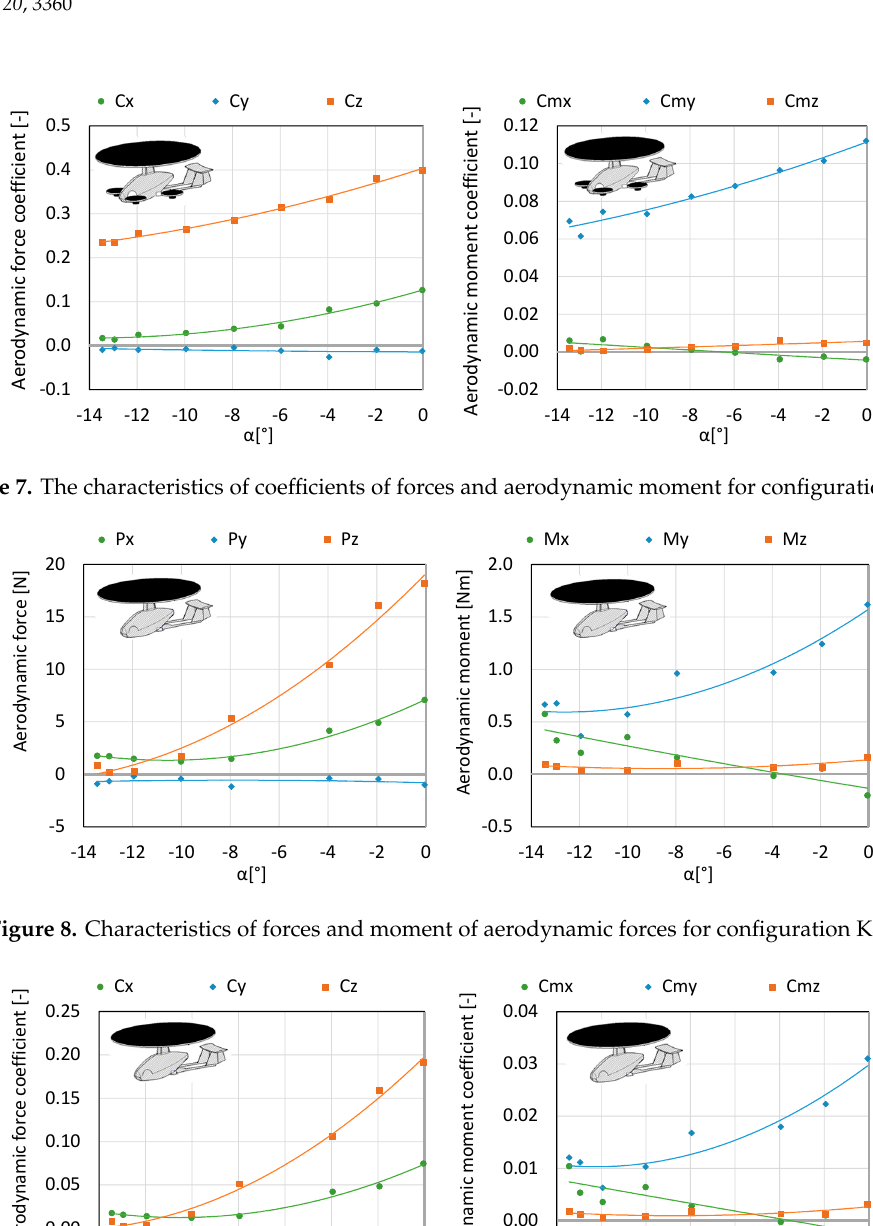
Figure 8. Characteristics of forces and moment of aerodynamic forces for configuration K3.